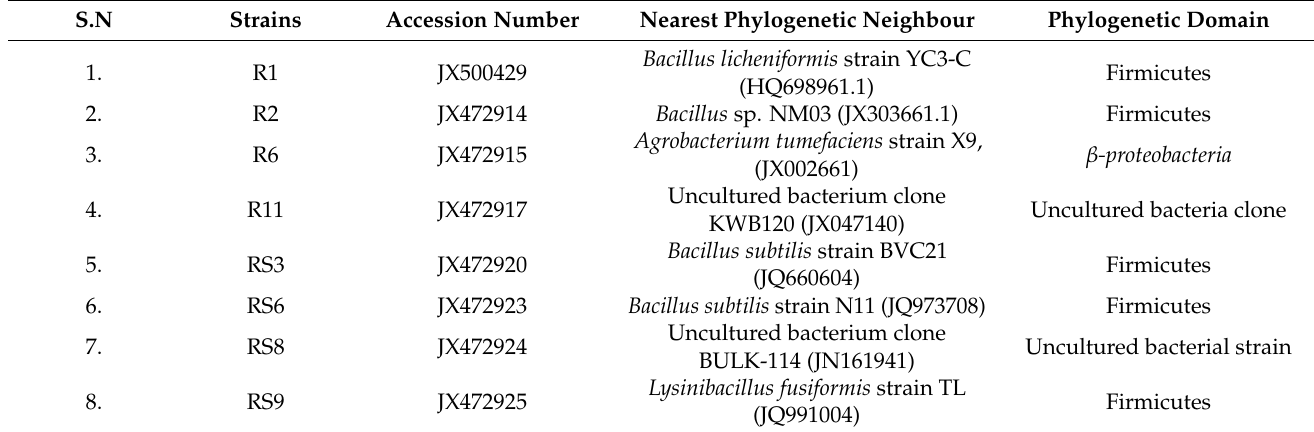
Table 2. The details molecular characteristics of endophytic bacterial strains.